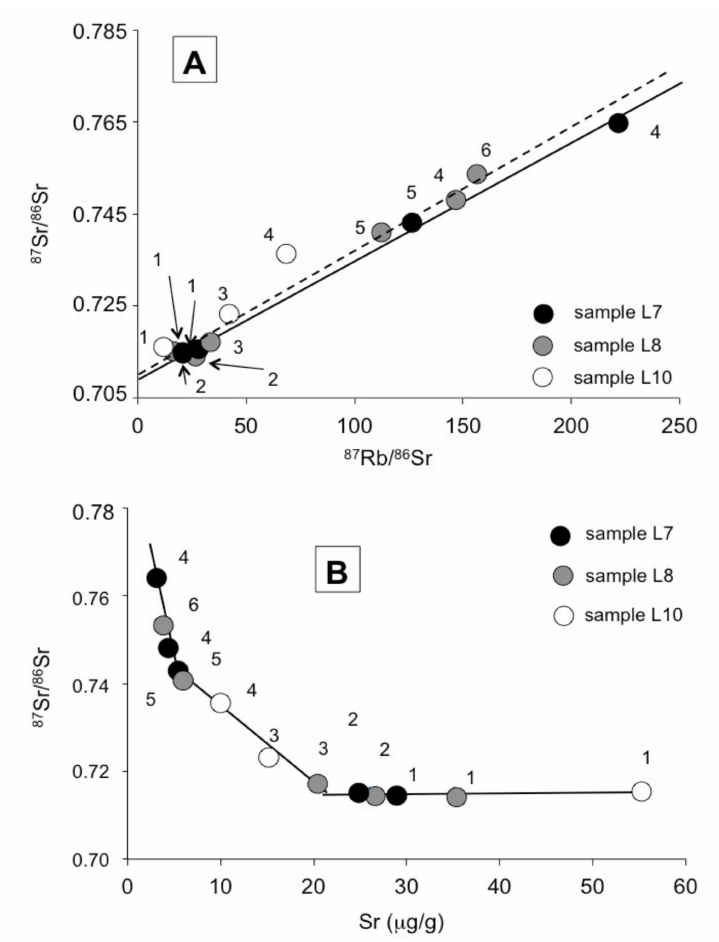
Figure 4. ( A ) Isochron diagram of the previously published Rb–Sr data, the full line mostly includes the data points of sample L7 and the dashed line are those of sample L8 and some of sample L10; ( B ) Diagram of the 87 Sr/ 86 Sr ratios of the analyzed residues with their Sr content. In both diagrams, the samples yield symbols colored differently with a numbering of the individual